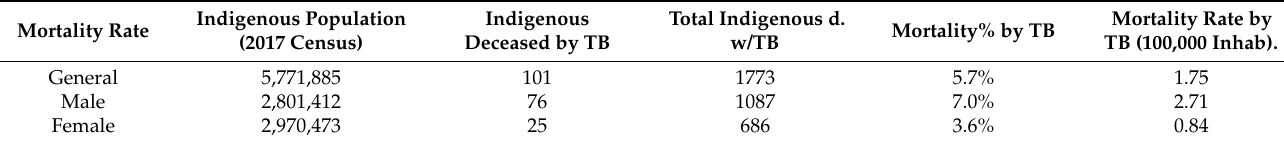
Table 1. TB mortality by